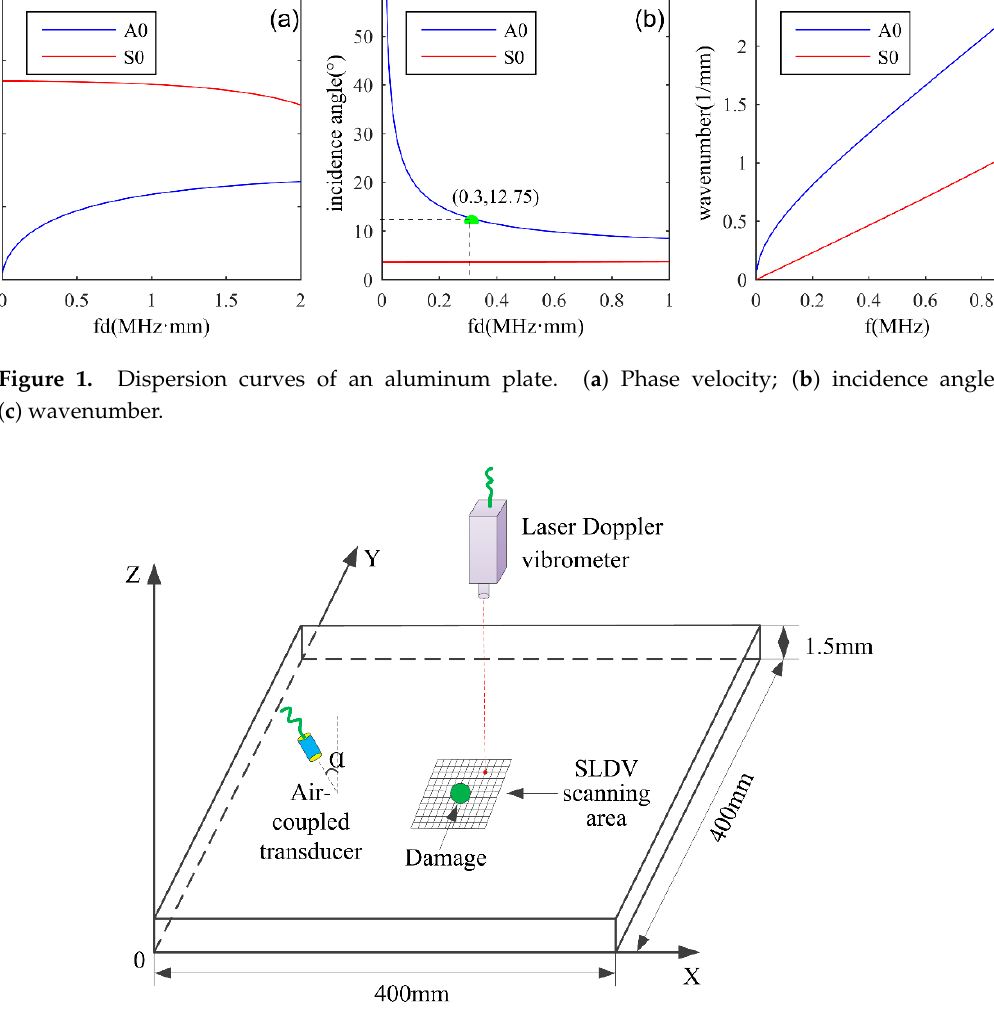
Figure 2. Schematic diagram of Lamb wave transmission and reception.